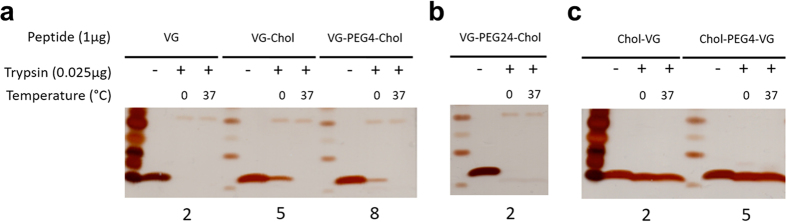
Protease sensitivity of HPIV3 derived peptides.The indicated peptides were incubated in the absence (−) or presence (+) of trypsin, at 0.025 µg/µl for 1 hr at 0 °C or 37 °C. The products of the reaction were subjected to reducing SDS-page gels and silver stained.